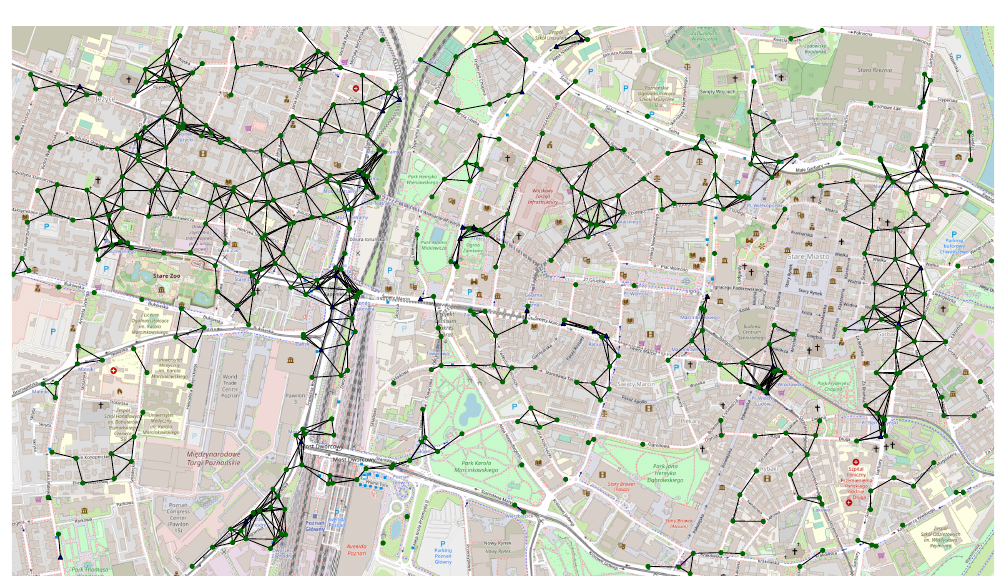
Figure 7. Wireless connectivity graph of a static sensor network modeled in the city center of Pozna´n on 27 November